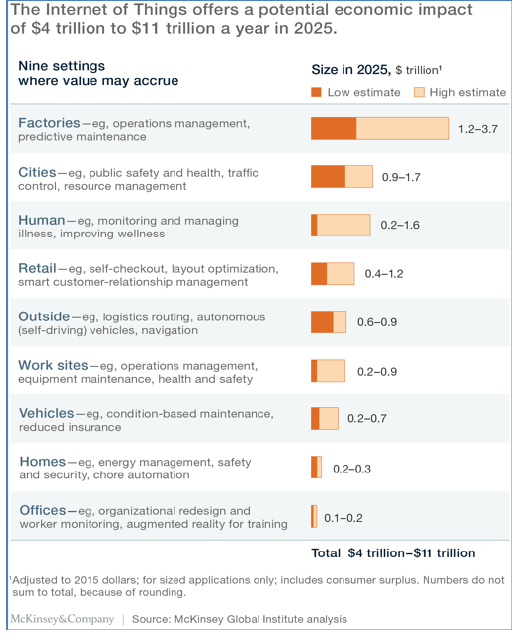
Figure 1. Economic impact of IoT Devices by